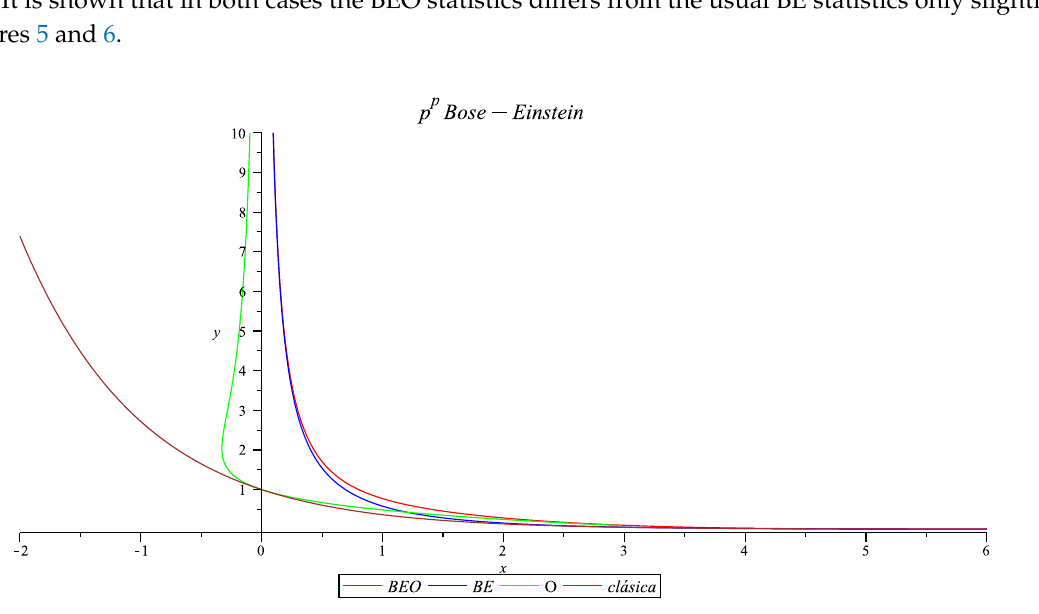
); and classical p l = e − β E l with g I ( β E l ) . The red line I ( β E ) and brown line to classical l I